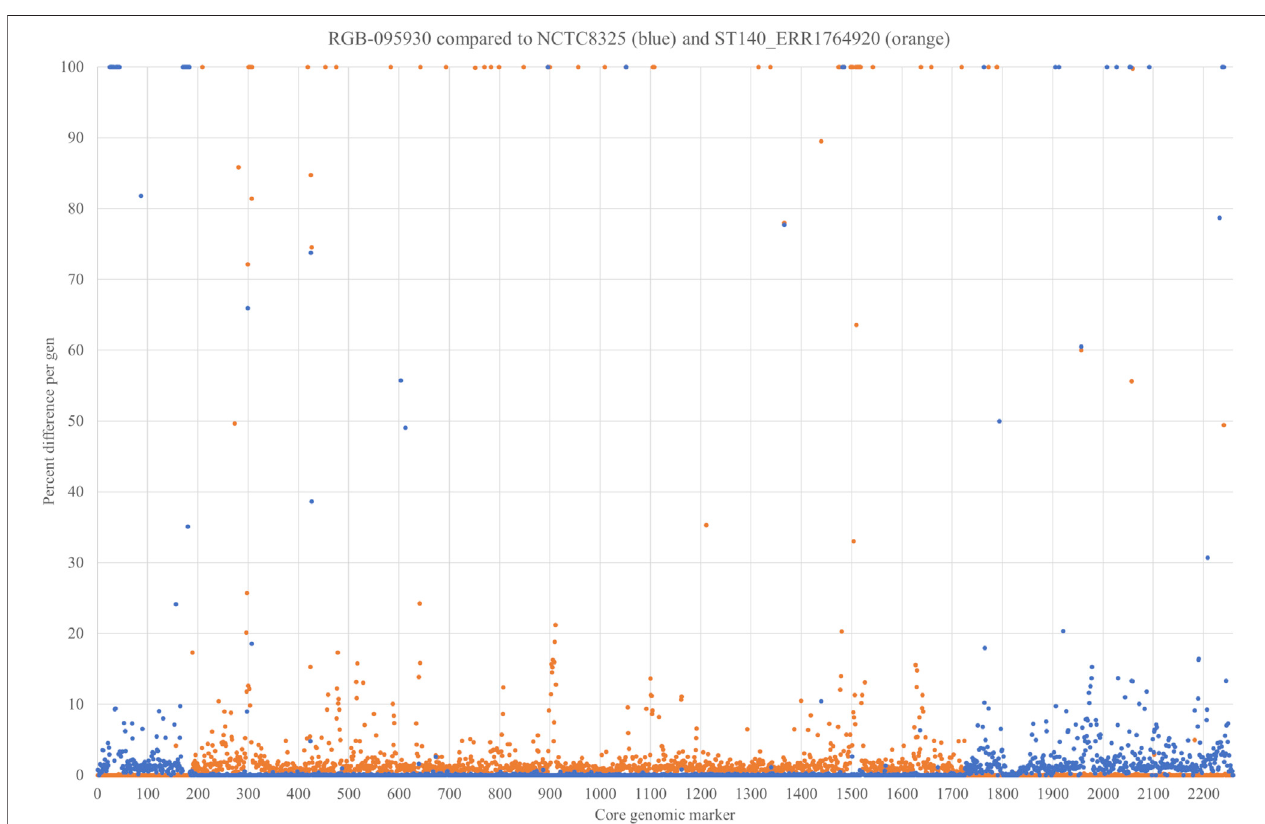
FIGURE 3 | SNP analysis comparing 2,259 non-motile genes of RGB-095930, NCTC8325 GenBank CP000253.1 and Kenyaseq6547225, SAMEA4394796 (https://www.ncbi.nlm.nih.gov/sra/ERR1764920). For each single gene, the number of differences ( Supplementary File S5 ) to the parent strains was counted and expressed as percentage. For genes that were present in one, but absent in the other strain, this percentage was set as